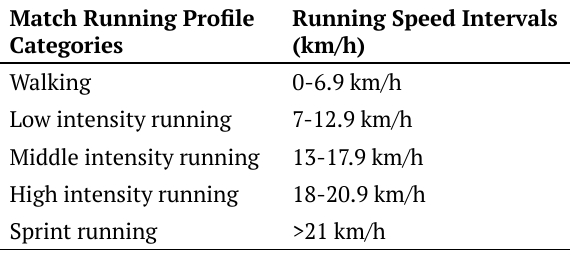
Table 1. Match Running Profile Parameters